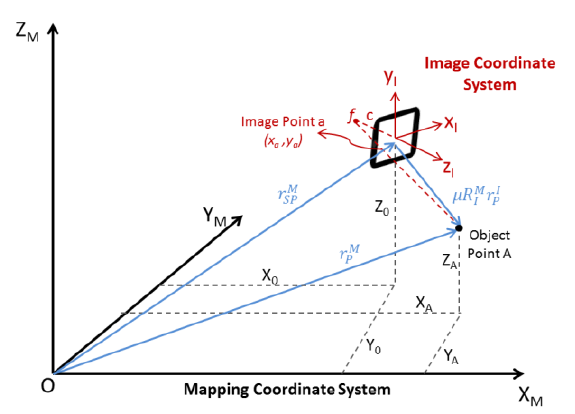
Figure 2. Mapping and Smartphone coordinate systems